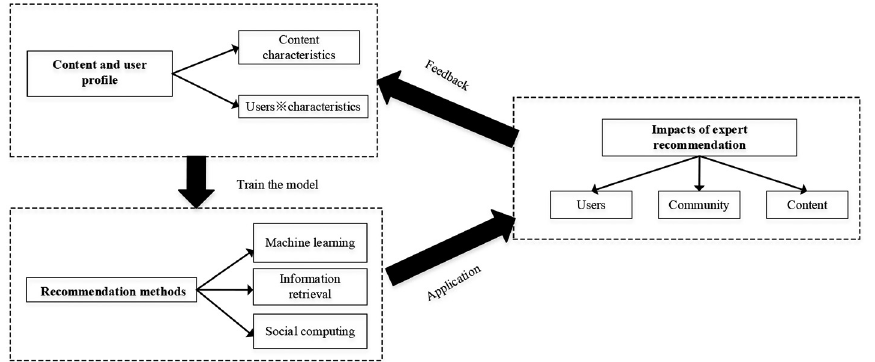
Figure 1. A general